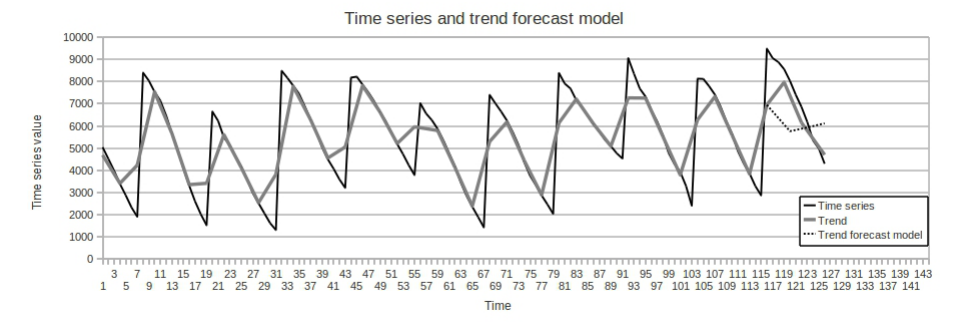
Figure 6. Trend forecast in the test part.